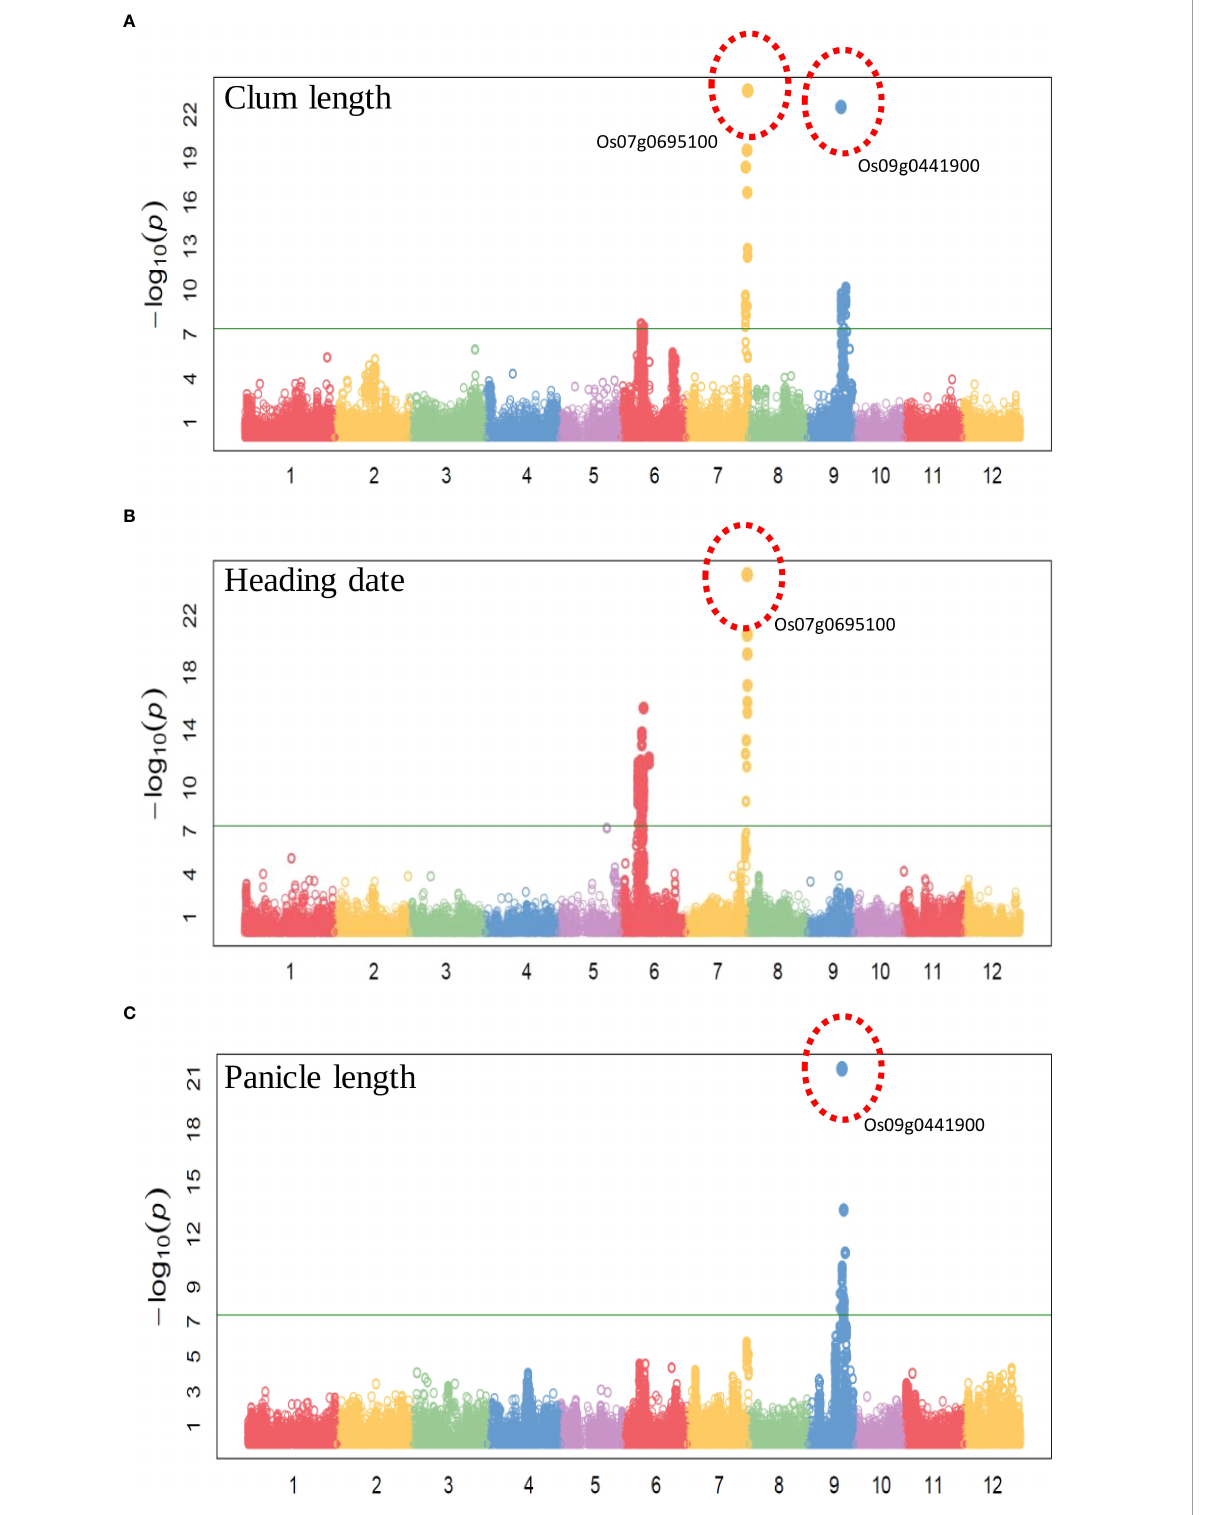
FIGURE 7 Manhattan plots of genome-wide association studies using the 580K _ KNU chip (A) Manhattan plot for Clum length, (B) Manhattan plot for Heading date, and (C) Manhattan plot for Panicle